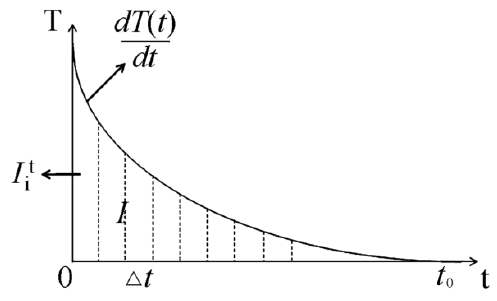
Figure 4. Temperature profiles of granite specimens during cooling: ( a ) after heating at 500 °C; ( b ) after heating at 200 °C.